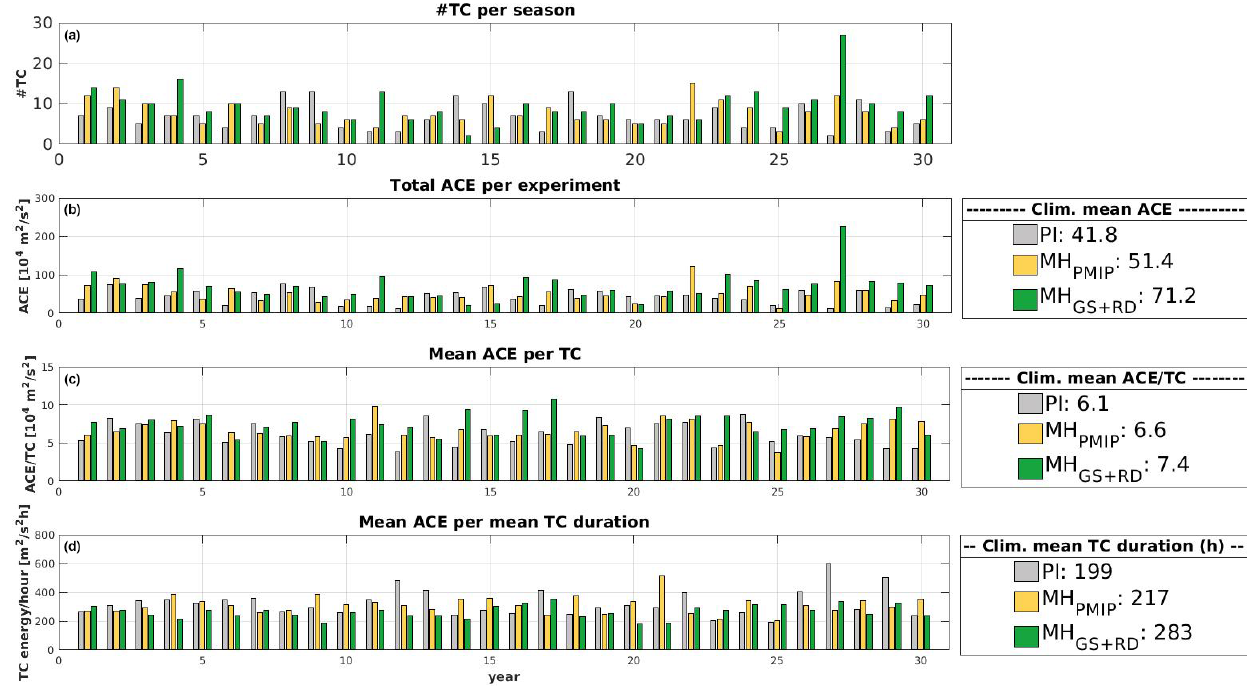
Figure 13. (a) Total number of cyclones per season for each experiment (30 years; gray: PI, yellow: MH PMIP and green: MH GS + RD ). (b) Total ACE (10 4 m 2 s − 2 ). (c) Mean ACE per cyclone per season (10 4 m 2 s − 2 ). (d) Mean ACE per cyclone normalized by the mean tropical cyclone duration in every season (10 4 m 2 s − 2 h − 1 ). Legends present the climatological mean of each distribution.